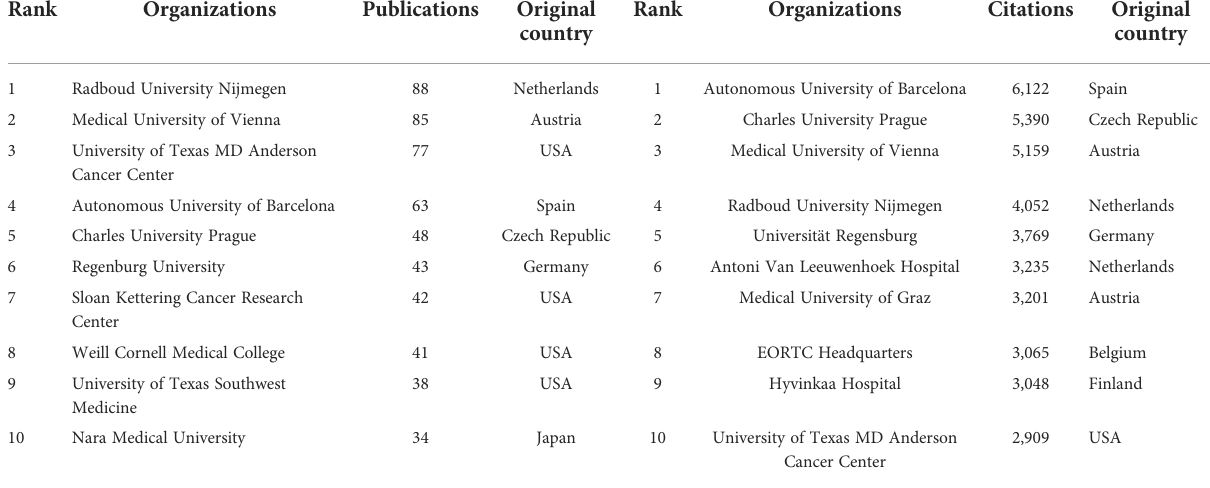
TABLE 2 Top 10 Institutions by publications and citations. Rank Organizations Publications Original